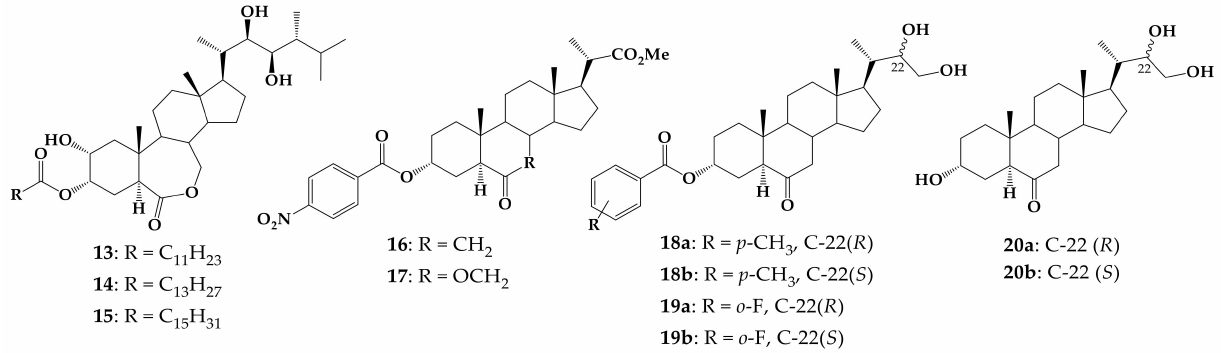
Figure 2. Structure of synthetic brassinosteroids (BRs) analogs conjugated in C-3 (compounds 13 – 19b ) and free synthetic analogs 20a and 20b